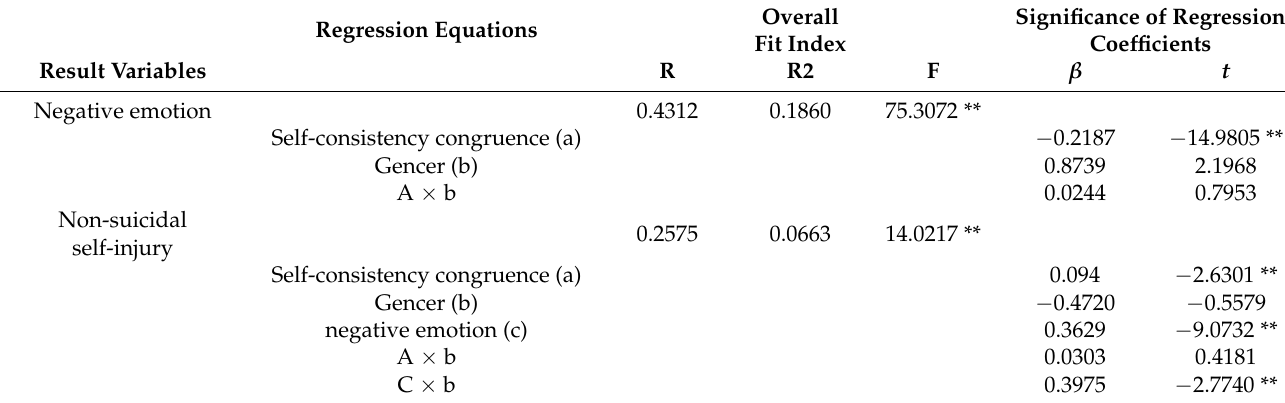
Table 3. Intermediary model with